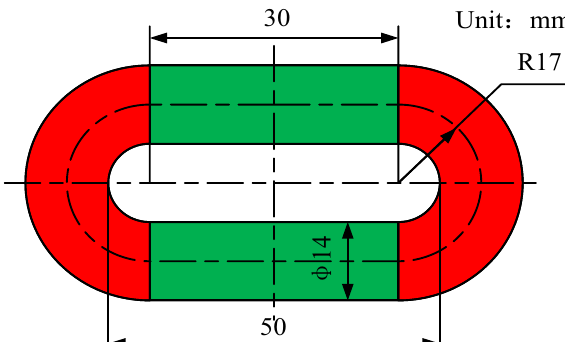
Figure 7. Dimensions of the round link.